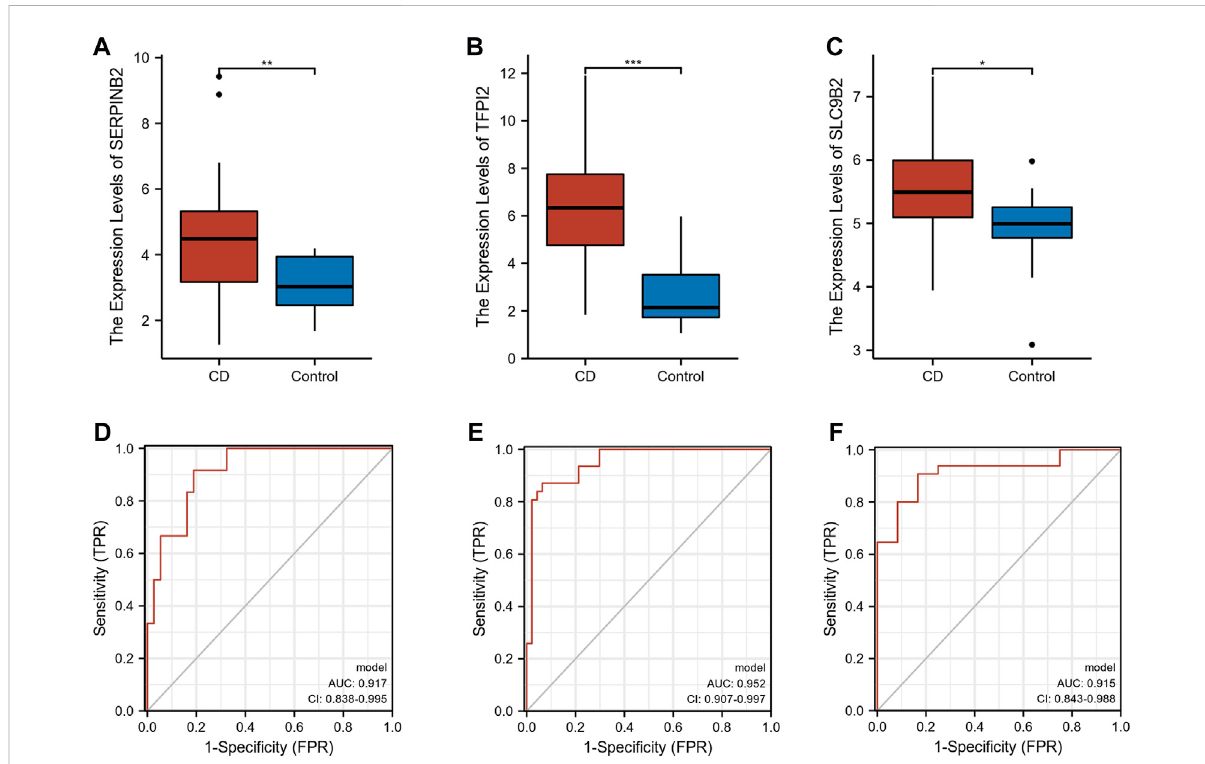
Exploration and validation of diagnostic values of selected biomarkers. (A – C) The expression levels of SERPINB2, TFPI2, and SLC9B2 in CD and normal tissues in GSE16879, respectively. (D – F) ROC of combined model in GSE16879, GSE179285, and GSE102133, respectively. (* p < 0.05, ** p < 0.01, *** p <